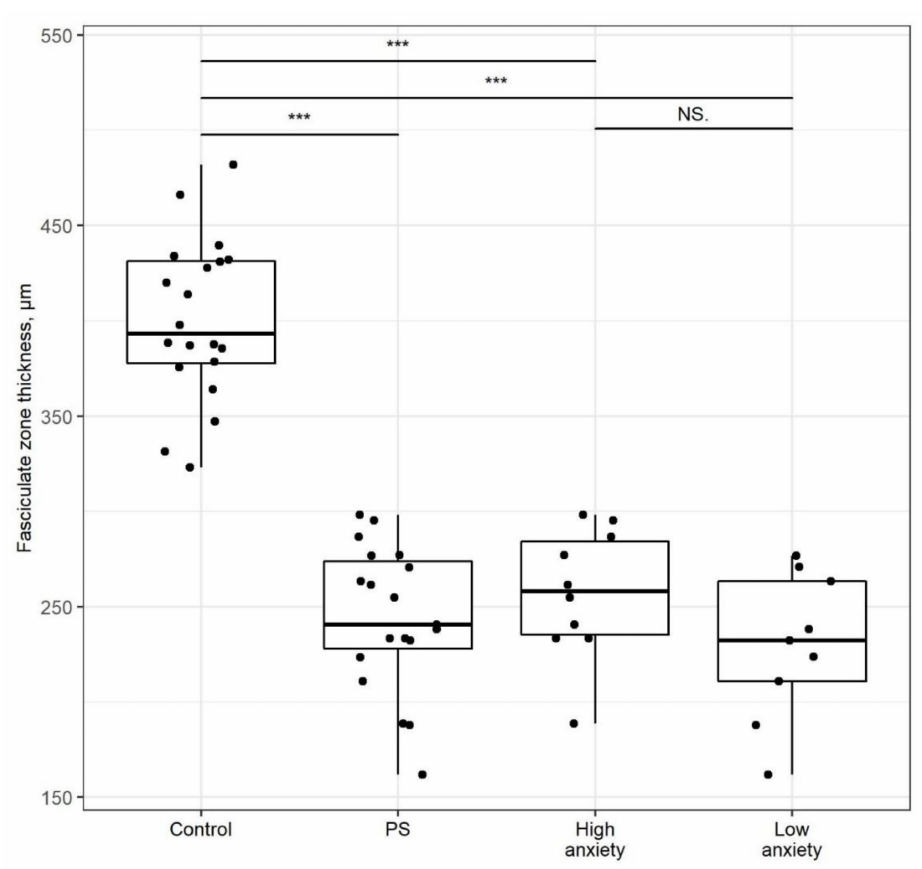
Figure 7. Adrenal zona fasciculata thickness is decreased after PSS . Zona fasciculata thickness of control, PSS, high- and low-anxiety groups. Differences in adrenal cortex thickness values among groups are shown as boxplots with dots rep-resenting individual data values and medians shown by horizontal lines. The boxes include the central 50% of the data, i.e., from the 25th to the 75th percentile. The whiskers include the data contained within 1.5 times the interquartile range. NS = p > 0.05; *** p < 0.001. p values determined in parametric